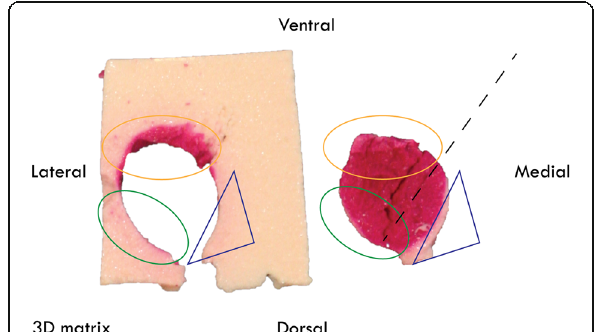
Fig. 5 Ablation results using 3D matrix guidance. The dashed line indicates the ablation needle orientation. The green circle indicates an area ablated closely to the edge with minimal ablation outside the target. The blue triangle indicates the danger triangle with zero ablation outside the target. The yellow circle indicates an edge of the nodule fully ablated as well as the area outside of the nodule showing